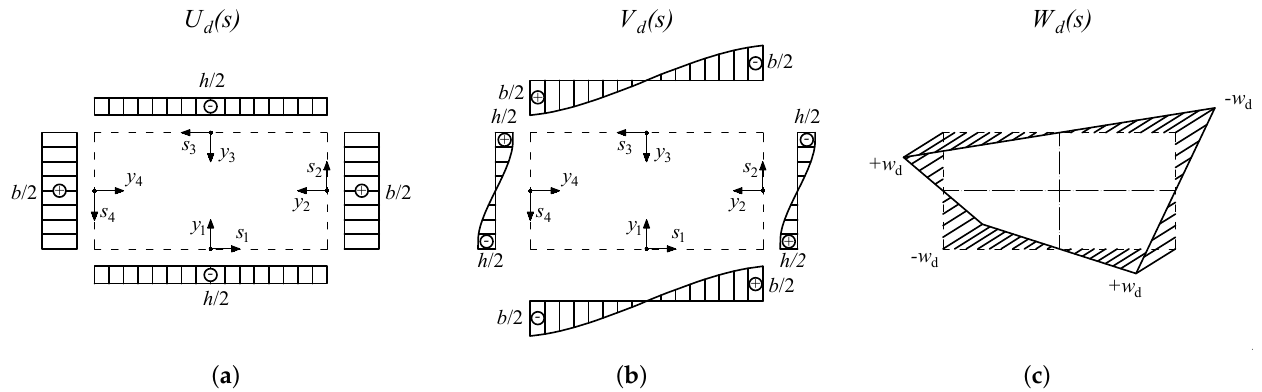
Figure 5. Distortional mode: ( a ) tangential displacements, ( b ) normal displacements, and ( c ) warping.